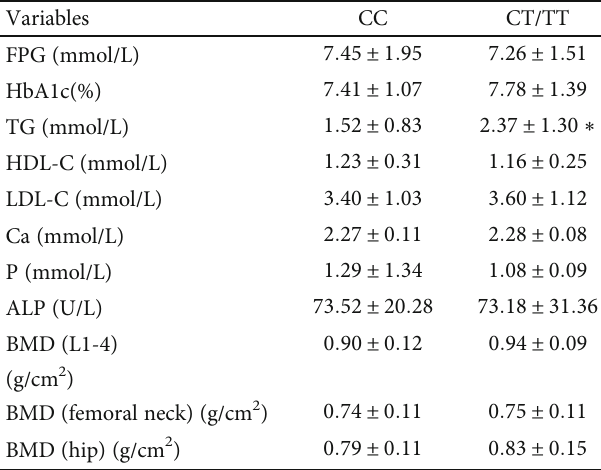
Table 4: Comparison of biochemical markers of di ff erent